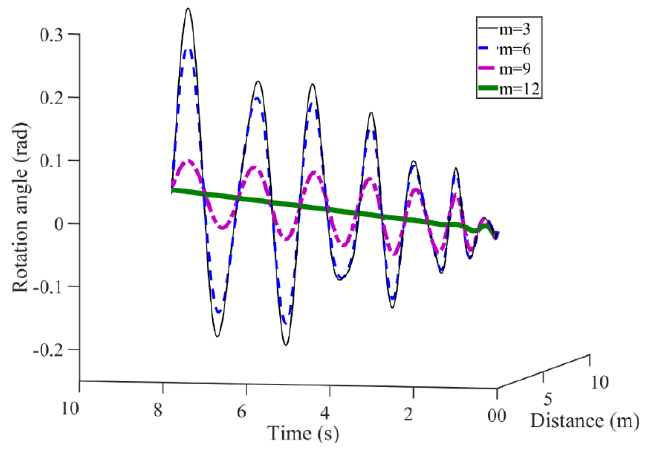
Figure 9. Impact of aggregation order on rotation angle.